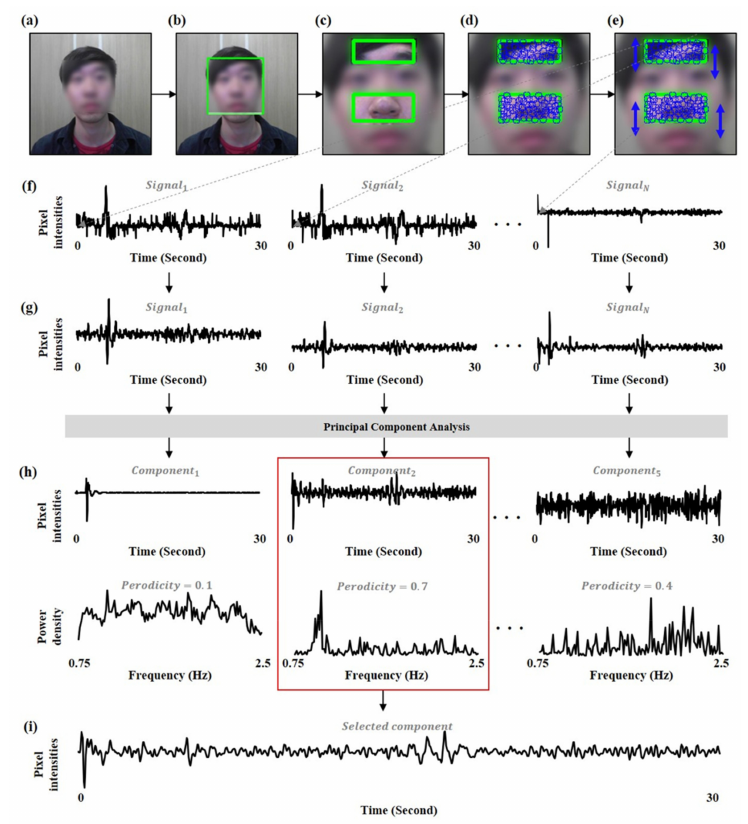
Figure 1. Overview of signal extraction and signal estimation. ( a ) facial video, ( b ) face detection, ( c ) area selection, ( d )facialpointextraction, ( e )facialpointtracking, ( f )signalextractionusingslidingwindowof30s, ( g ) bandpass filtering, ( h ) principal component analysis, ( i ) component selection with highest